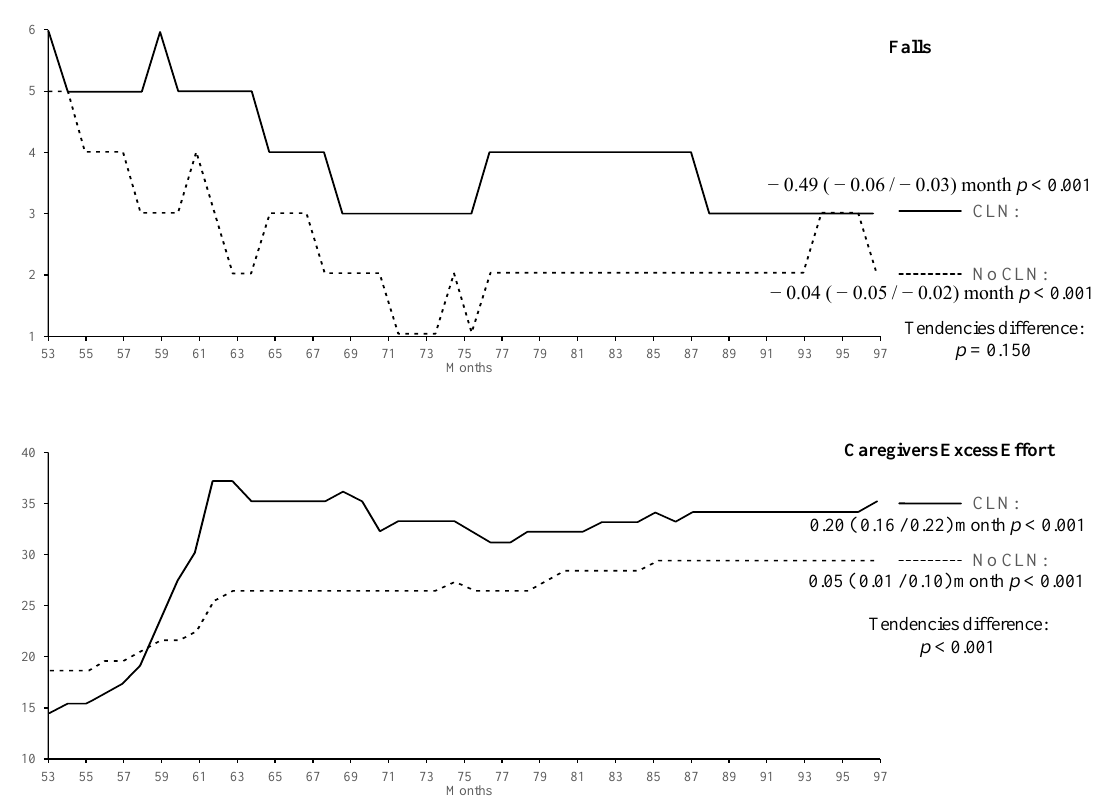
Figure3. Estimationoutcomesofthepatients’outcomeindicators, tendency, anddi ff Figure 3. Estimation outcomes of the patients’ outcome indicators, tendency , and difference signification.